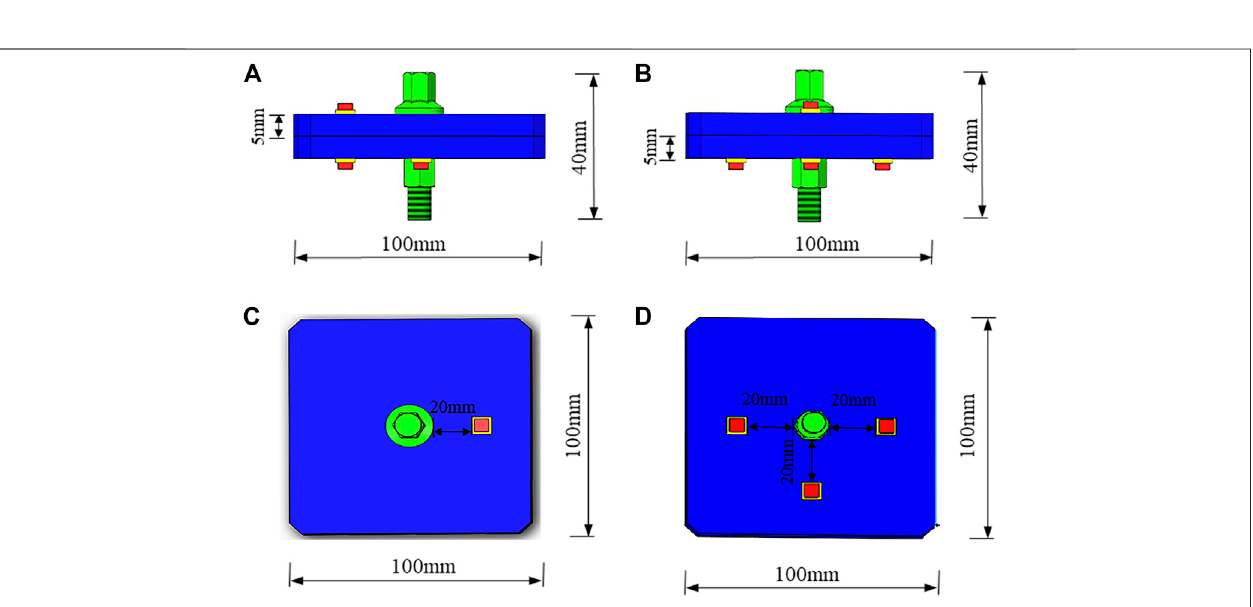
FIGURE 8 | Detailed geometry of the specimen. (A) Front view. (B) Side view. (C) Up view. (D) Bottom view.